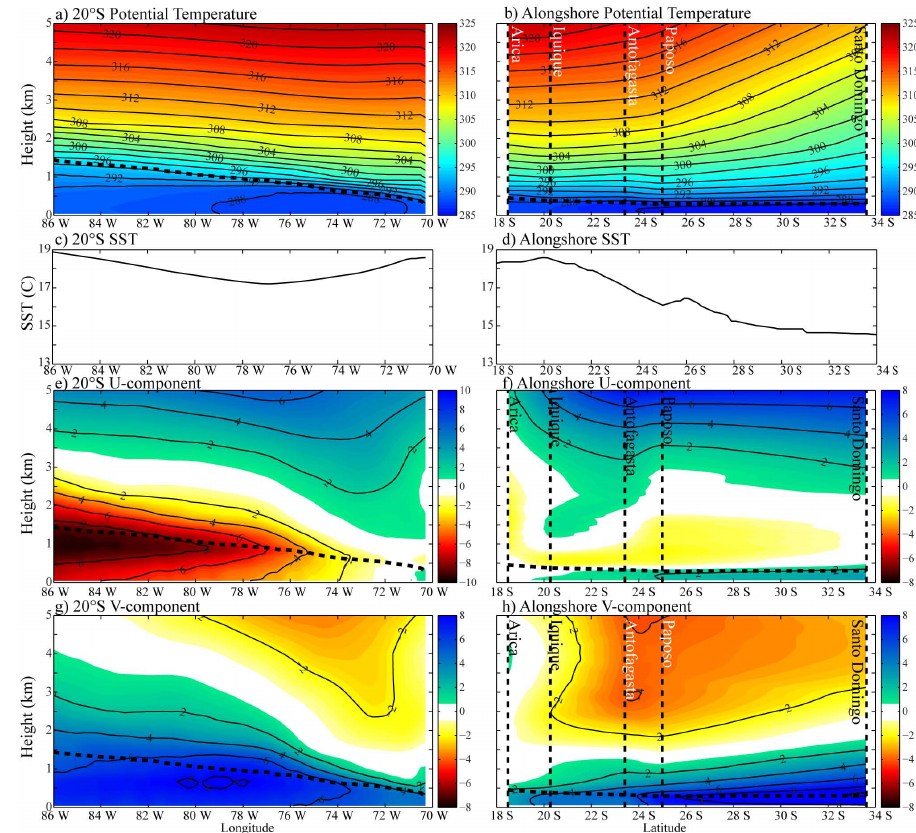
Fig. 7. Same as Fig. 6, but using WRF